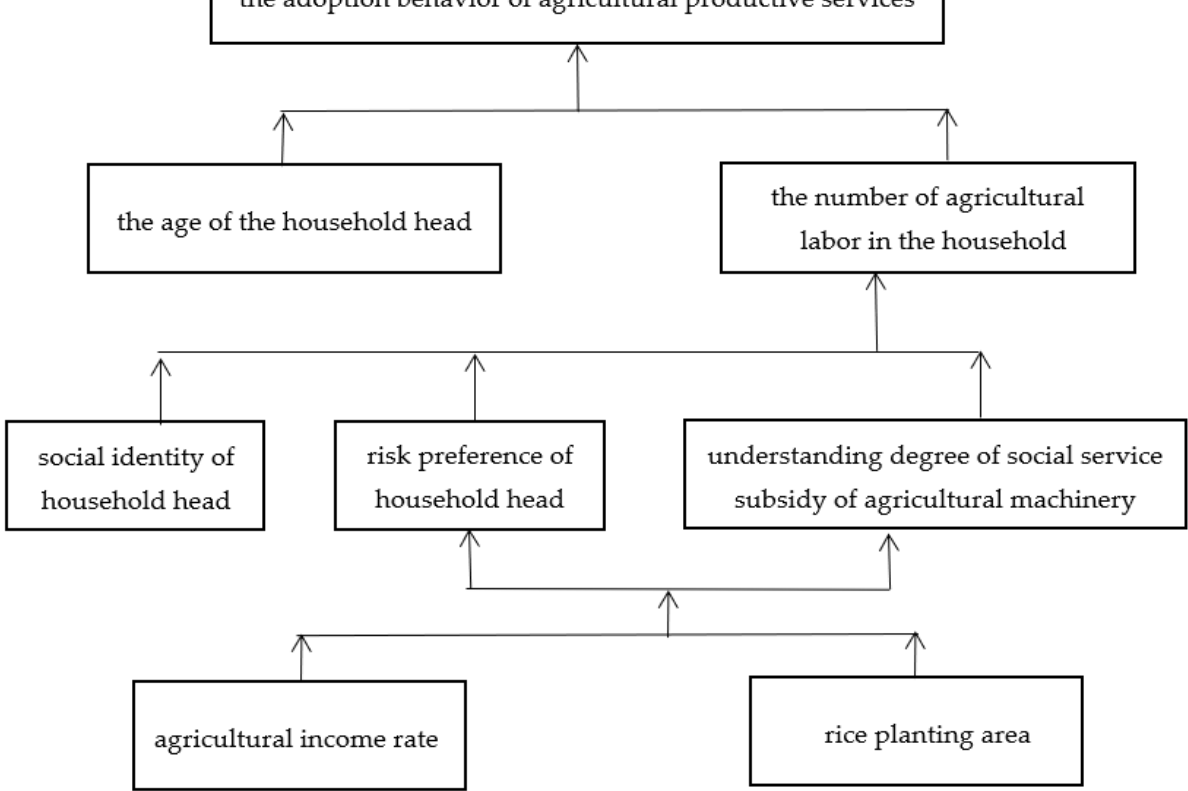
Figure 2. Interpretative structural model of the influencing factors.